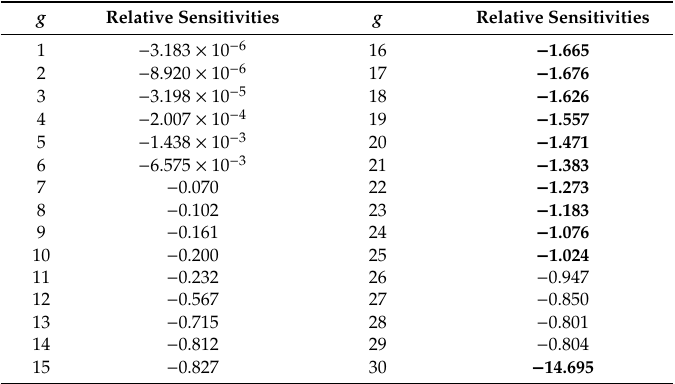
Table 9 lists the values for the elements of the submatrix S ( 2 ) (cid:16) (cid:17)(cid:16) (cid:17) ∂ 2 L / ∂ N ∂σ g N 5,2 σ g / L , g = 1, . . . , 30, comprising the 2nd-order mixed relative sensitivities i = 5, m = 2 t ,6 t , k = 6 of the leakage response with respect to the isotopic number density of isotope 5 (C) and the microscopic total cross sections of isotope 6 ( 1 H). This submatrix includes 11 elements, highlighted in bold, which have absolute values greater than 1.0. These 11 elements involve the total cross sections of isotope 1 H for energy groups g = 16, . . . , 25, and g = 30, respectively. The largest negative value in this submatrix (cid:16) (cid:17) = 30 = − 14.695. N 5,2 , σ g is S ( 2 ) t ,6 Table 9. Second-Order Relative Sensitivities S ( 2 ) g Relative Sensitivities g Relative Sensitivities